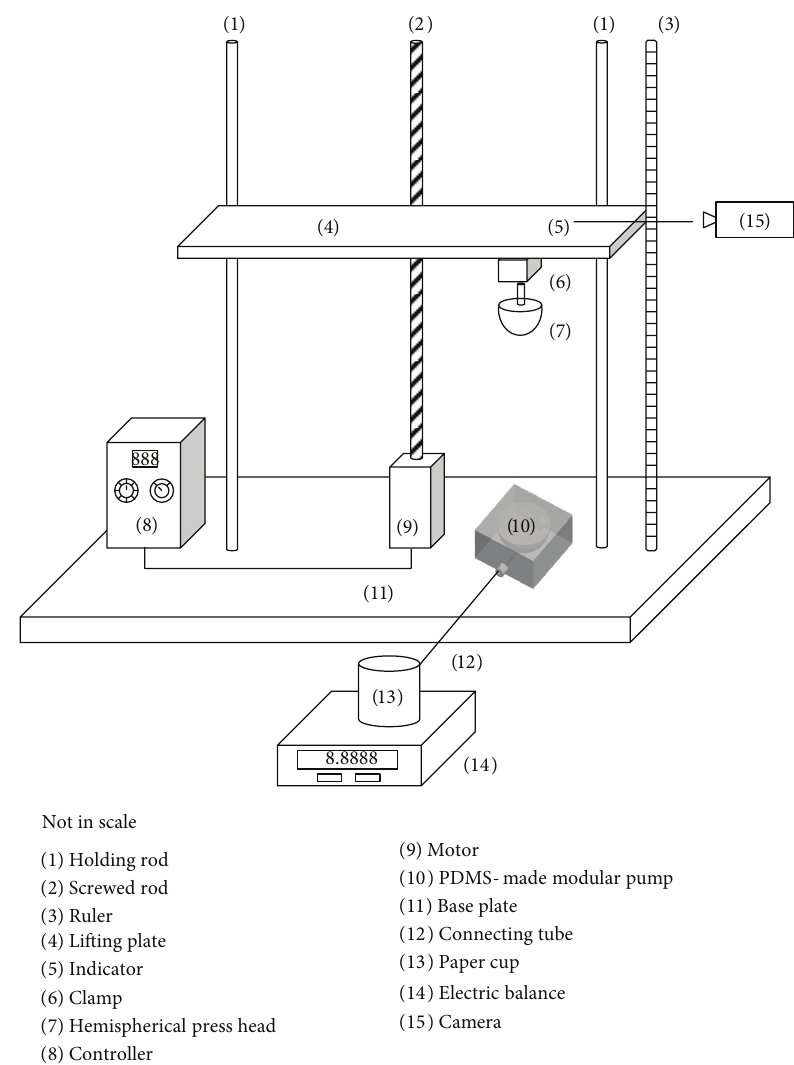
Figure 2: Scheme of custom-made apparatus for hydraulic capacitance measurement of modular membrane